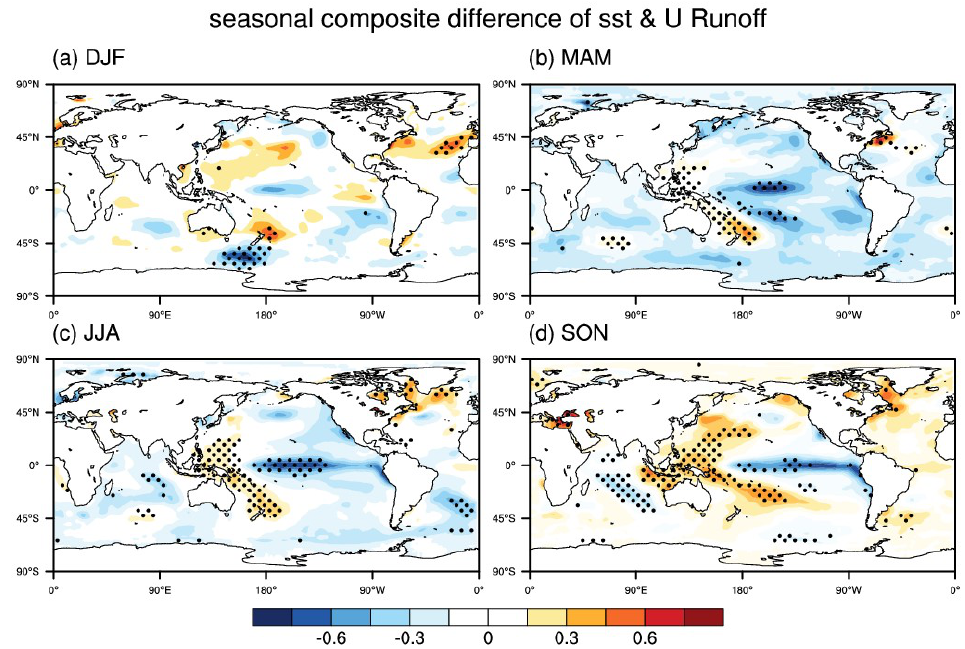
Figure 4. The composite difference of Sea surface temperature (SST) from the previous winter to autumn. (high—low upper July–August–September (JAS) runoff years; color shadings). Black dots are statistically significant at the 95% confidence level on the basis of a Student’s t -test. In this study, DJF means December-January-February, MAM means March-April-May, JJA means June-July-August and SON means